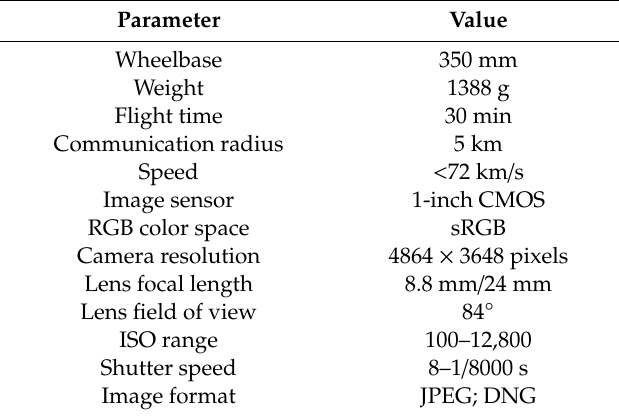
Figure 3. The acquisition and pretreatment of unmanned aerial vehicles (UAV) RGB imagery, including camera parameter setting, flight route design, UAV fights, and image mosaic and correction. GCP is the abbreviation of the ground control point. Table 1. Main parameters of UAV RGB imagery acquisition system.